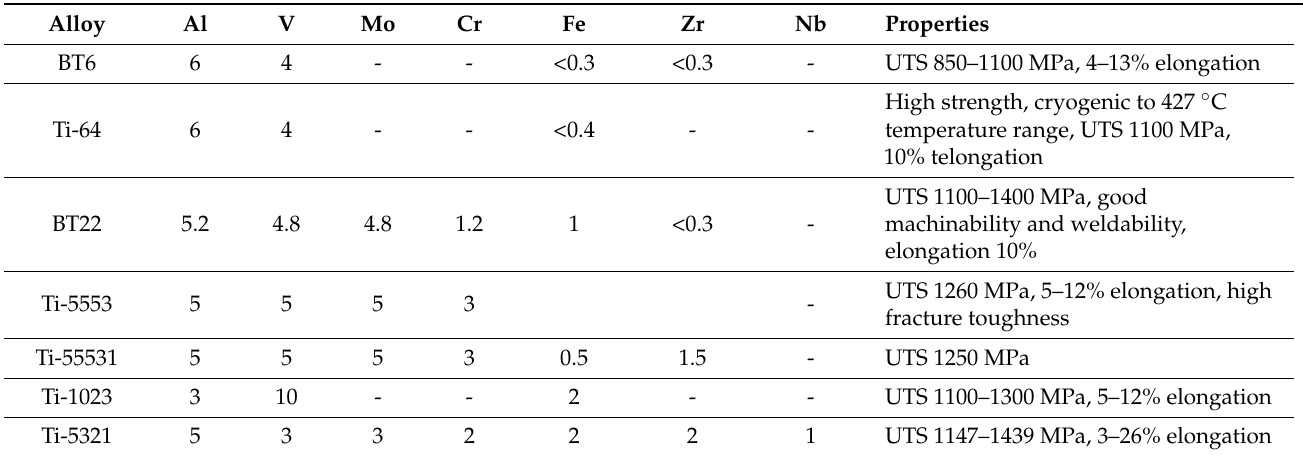
Table 1. Composition of some α + β titanium